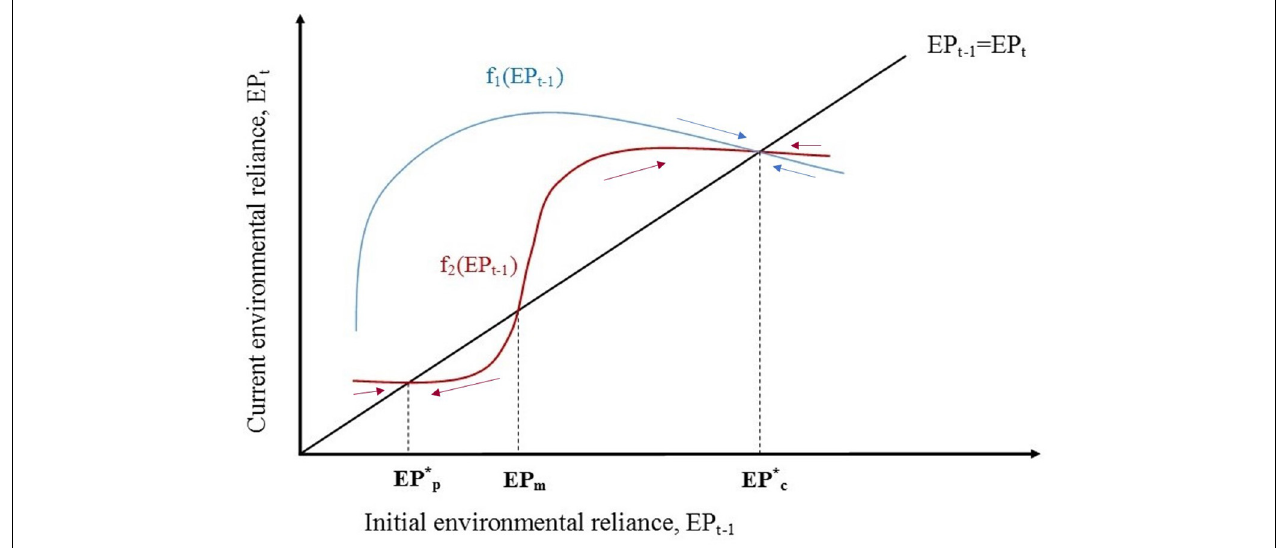
FIGURE 2 | Hypothetical household environmental reliance